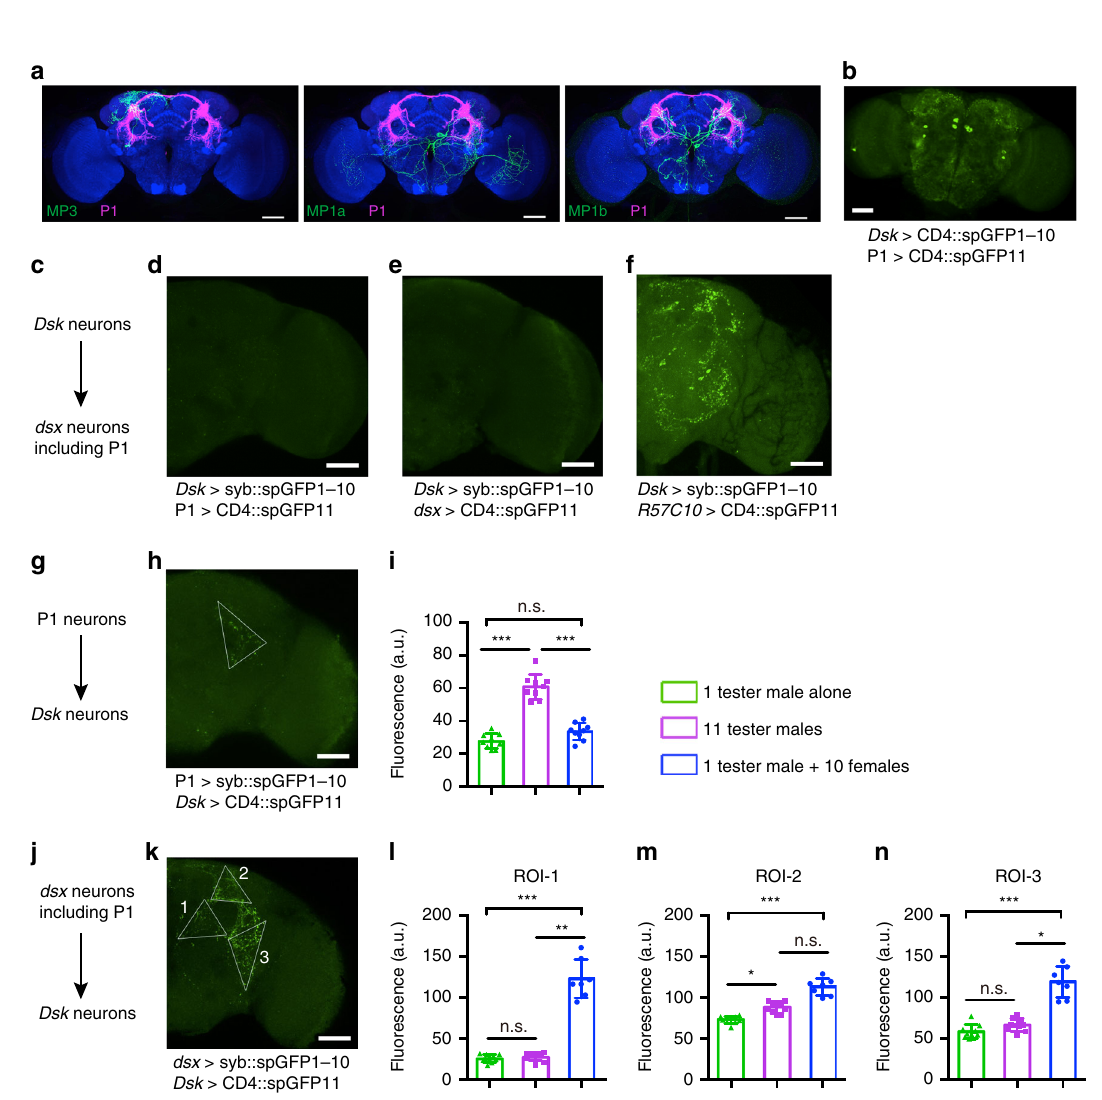
Fig. 4 Dsk and P1 neurons function antagonistically to regulate male sexual arousal. a Co-activation of Dsk and P1 neurons results in intermediate courtship levels. n = 24, 19, 17, 24, 24, 20, 24, 24, 20, 24, 24, 24, 24, and 24 respectively (from left to right). Genotypes as indicated. p < 0.05, Kruskal – Wallis test. * p < 0.05, ** p < 0.01, *** p < 0.001, and p > 0.1 (n.s.) post hoc Dunn ’ s multiple com p arisons test. b , c Dsk and P1 neurons oppositely regulate sleep. n = 60, 56, 57, and 60 respectively. p < 0.001, Kruskal – Wallis test. *** p < 0.001 and p > 0.99 (n.s.), post hoc Dunn ’ s multiple comparisons test. d , e Spontaneous walking velocity of individual males at permissive temperature (22 °C). n = 24, 24, 36, and 19, respectively. p = 0.07, One-way ANOVA. f – j Dsk and P1 neurons oppositely regulate spontaneous walking velocity. n = 24, 24, 32, and 19, respectively. For overall mean velocity ( g ): p < 0.001, One-way ANOVA. *** p < 0.001 and p > 0.1 (n.s.), post hoc Tukey ’ s multiple com p arisons test. For mean velocity from 0.5 h to 1.5 h ( h ): p < 0.001, Kruskal – Wallis test. * p < 0.05 and p > 0.99 (n.s.), post hoc Dunn ’ s multiple comparisons test. For mean velocity from 12 h to 13 h ( i ): p < 0.001, One-way ANOVA. *** p < 0.001 and p > 0.1 (n.s.), post hoc Tukey ’ s multiple comparisons test. For mean velocity from 23 h to 24 h ( j ): p < 0.001, Kruskal – Wallis test. * p < 0.05 and p > 0.99 (n.s.), post hoc Dunn ’ s multiple comparisons test. k Representative walking trajectories in a visual-induced walking assay during a 6-min observational time. l , m Activation of Dsk neurons does not affect visual tracking ability or visual-induced walking speed. n = 20, 20, 12, and 18, respectively. For visual tracking performance: p = 0.3265, Kruskal – Wallis test; for walking speed: p = 0.3544, Kruskal – Wallis test. n.s. not signi fi cant. Error bars indicate SEM. Source data are provided as a Source Data fi le